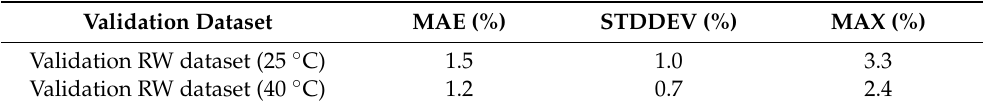
Table 3. SOH estimation accuracy of CNN for different test cases. Case Study